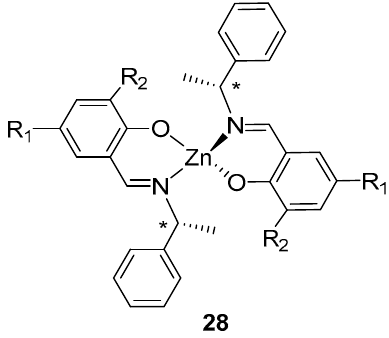
Figure 7. Structure of chiral ZnL 2 complexes.